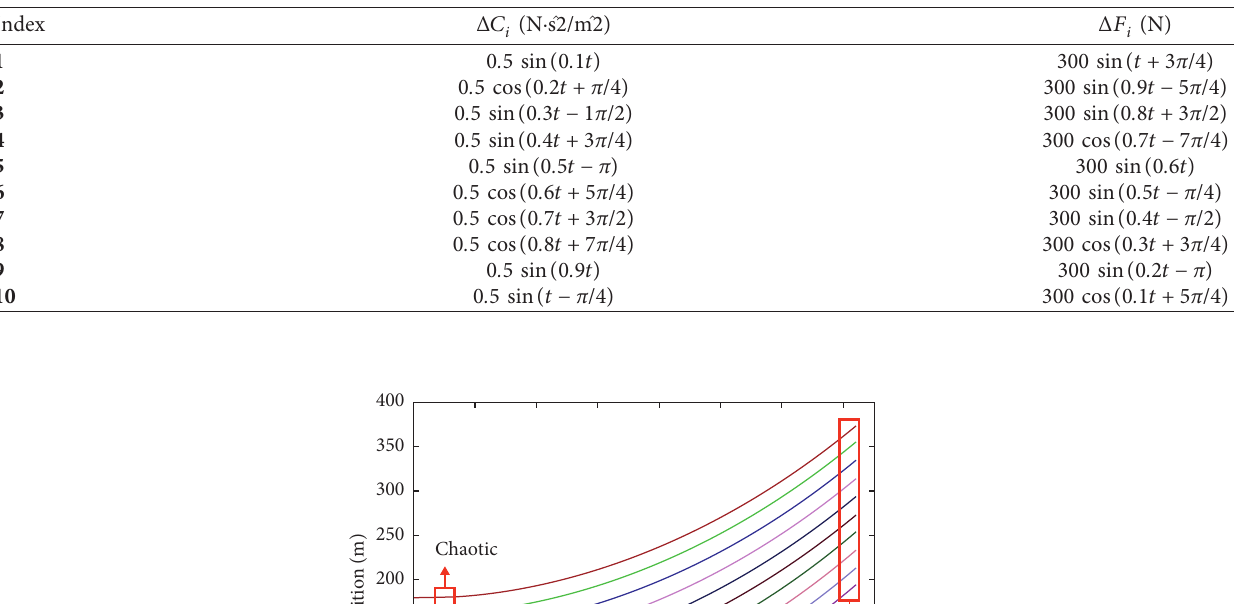
Table 2: Parameters’ uncertainty.